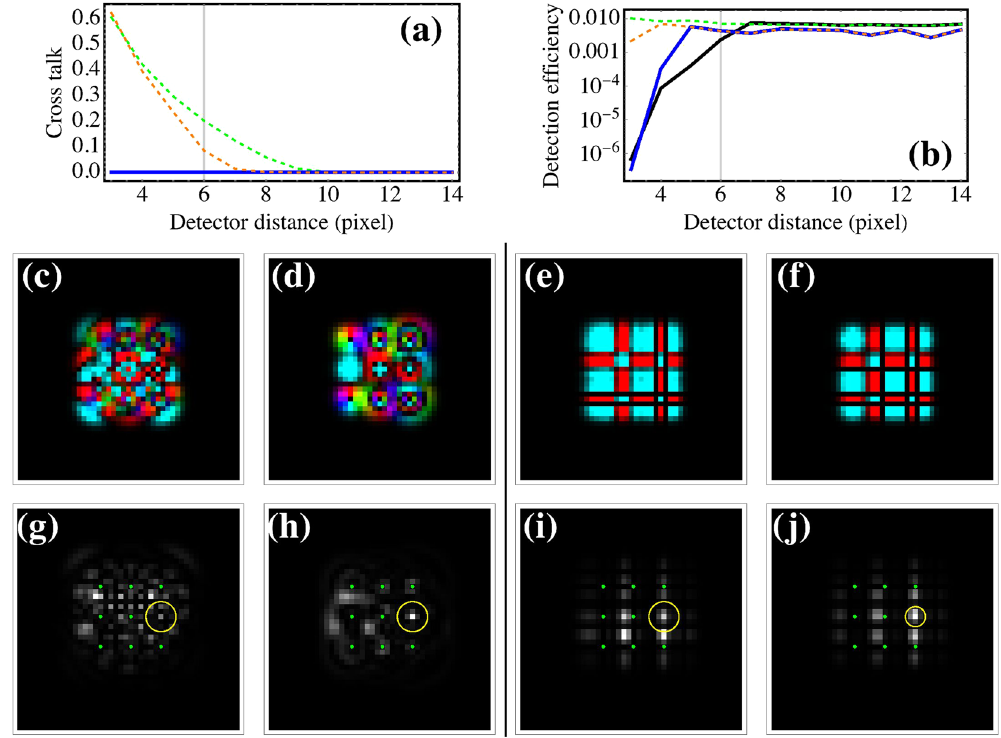
Figure 2. Comparison between the eigenmask method and carrier frequency modulation (CFM) approach 23 . ( a ) Cross talk as a function of detector distance for Laguerre-Gaussian (black curve: eigenmask; green dashed curve: CFM) and Hermite-Gaussian beams (blue curve: eigenmask; orange dashed curve: CFM). ( b ) Detection efficiency as a function of detector distance for Laguerre-Gaussian and Hermite-Gaussian beams (same coloring scheme as in part a). ( c – f ) Phase (hue) and amplitude (luminosity) of the Fourier transform of the decomposition mask and ( g – j ) example decomposition output intensity with ( c , g ) LG 21 using the eigenmask ( d , h ) LG 21 using CFM ( e , i ) HG 12 using the eigenmask and ( f , j ) HG 12 using CFM (Code available online) 27